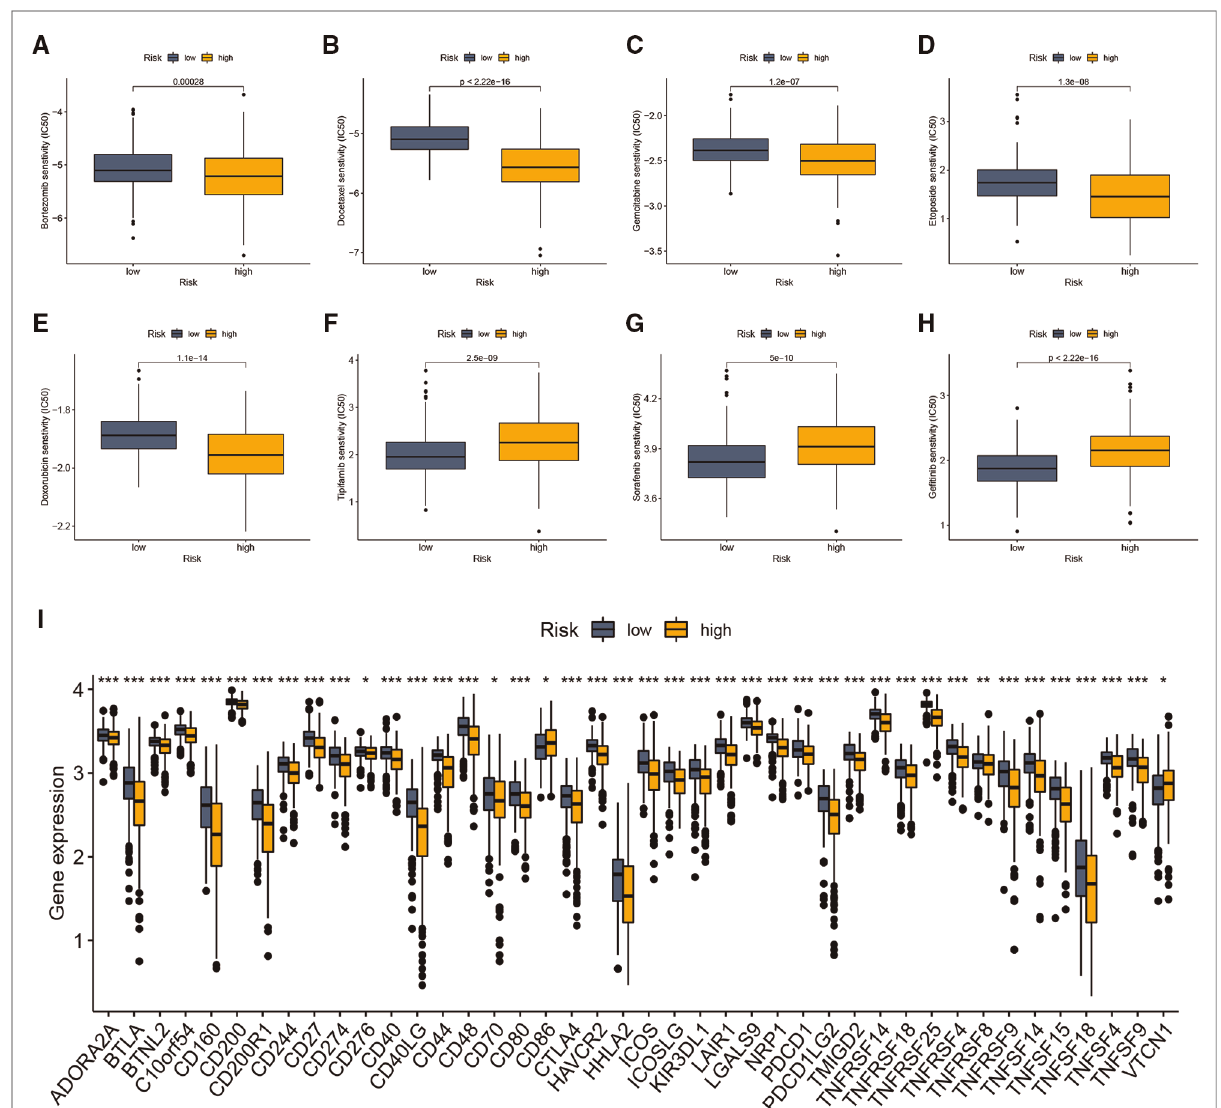
FIGURE 5 The predictive value of the cuproptosis-related signature in chemotherapy and immunotherapy. ( A – H ) Drug sensitivity analysis between two CRG- score groups. ( I ) The relationship between immune checkpoints and the CRG-score. * p <0.05, ** p <0.01, *** p